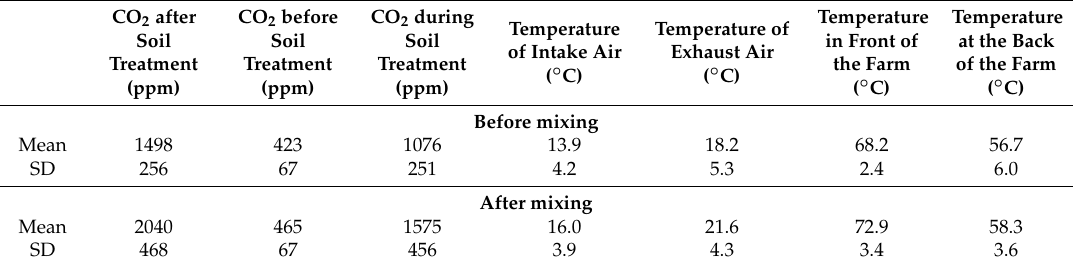
Table 3. Carbon dioxide concentration and temperature according to process of soil